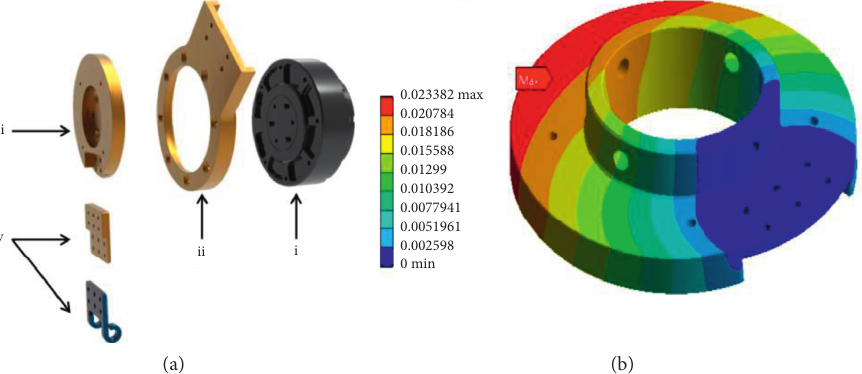
Figure 5: (a) Mechanical design of hip joint: (i) quasi-direct drive motor, (ii) connecting element from lumbar support backrest to hip joint, (iii) motor flange, and (iv) connecting element from hip to thigh. (b) The FEA result of total deformation of flat.